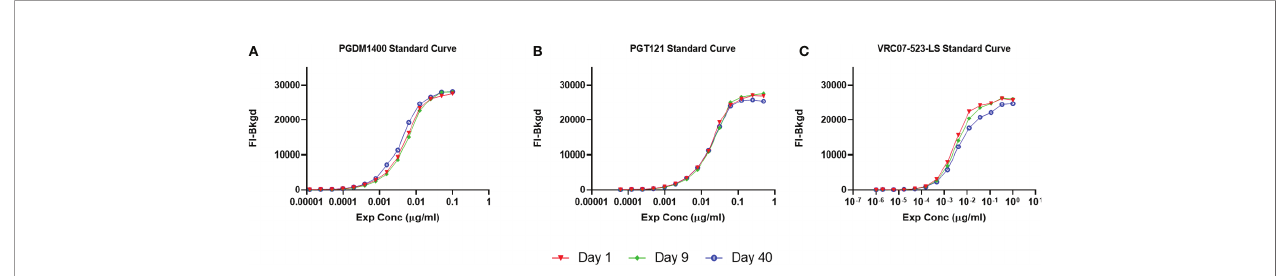
FIGURE 9 | Intermediate Precision of the PGDM1400/PGT121/VRC07-523-LS standard curve. PGDM1400, PGT121 and VRC07-523-LS were co-titrated in 1:100 NHS in assay diluent by the same operator over a timeframe of 40 days. Curves for PGDM1400 (A) , PGT121 (B) and VRC07-523-LS (C) are graphed to demonstrate the intermediate precision of this assay.